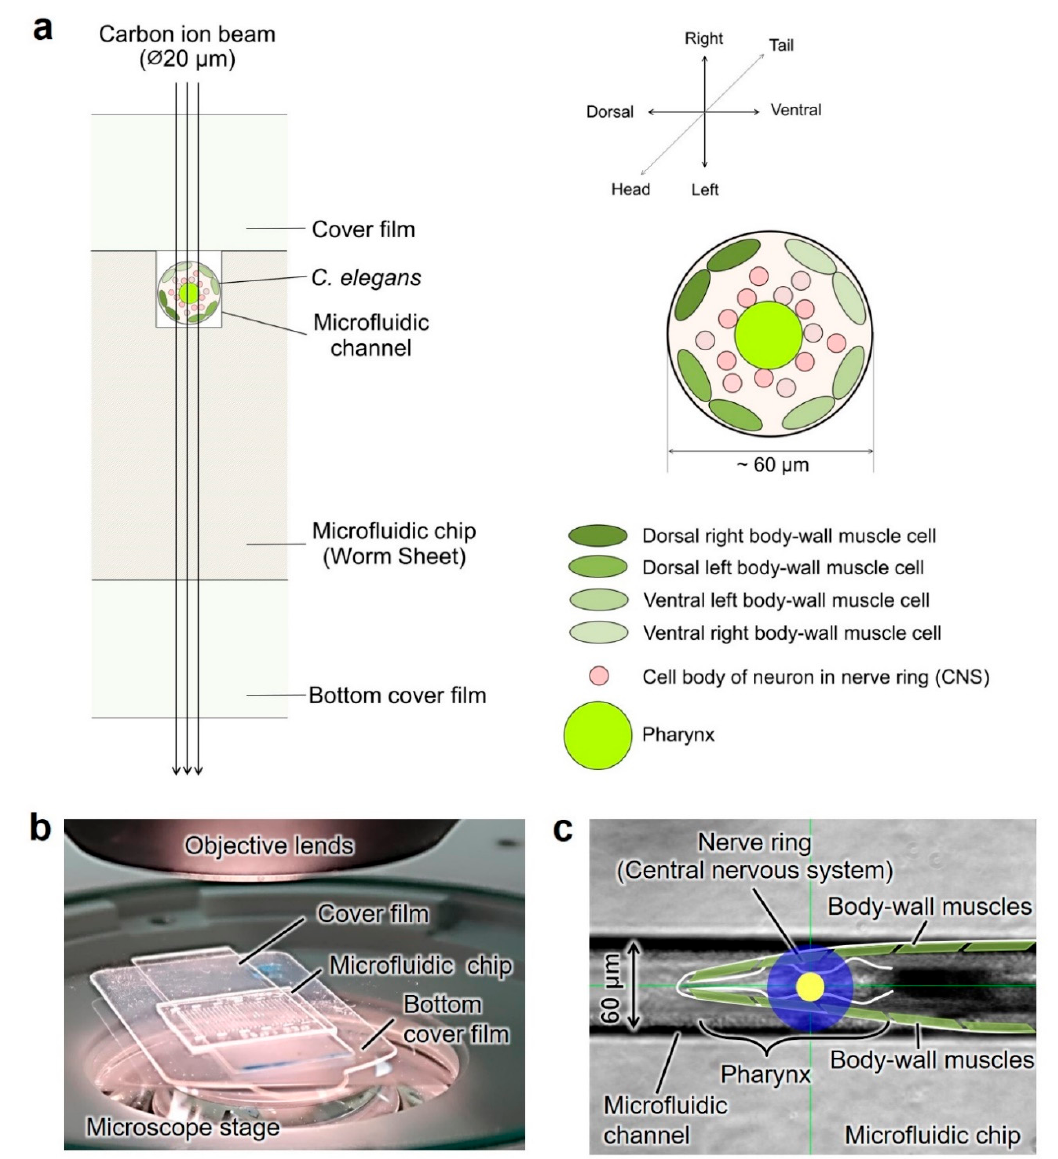
Figure 1. Schematic of the CNS-targeted irradiation of individual live C. elegans using a microfluidic chip. ( a ) Cross-sectional view of CNS-targeted irradiation of a live C. elegans enclosed in a microfluidic channel of a microfluidic chip. Anatomical structure of an individual C. elegans in the right panel was compiled with reference to a previous report [3]. ( b ) Schematic of a 300-µm, ultra-thin, ion-penetrable, wettable, microfluidic chip (Worm Sheet IR) enclosing live C. elegans individuals in the microfluidic channels. ( c ) Overhead view of the anterior body of an individual live C. elegans enclosed in a straight microfluidic channel of a microfluidic chip. The whole nerve ring in a ⌀ 60-µm micro-aperture region (filled in blue) or the center of the nerve ring (CNS) in a ⌀ 20-µm micro-aperture region (filled in yellow) were targeted and irradiated with an exact number of carbon ions.